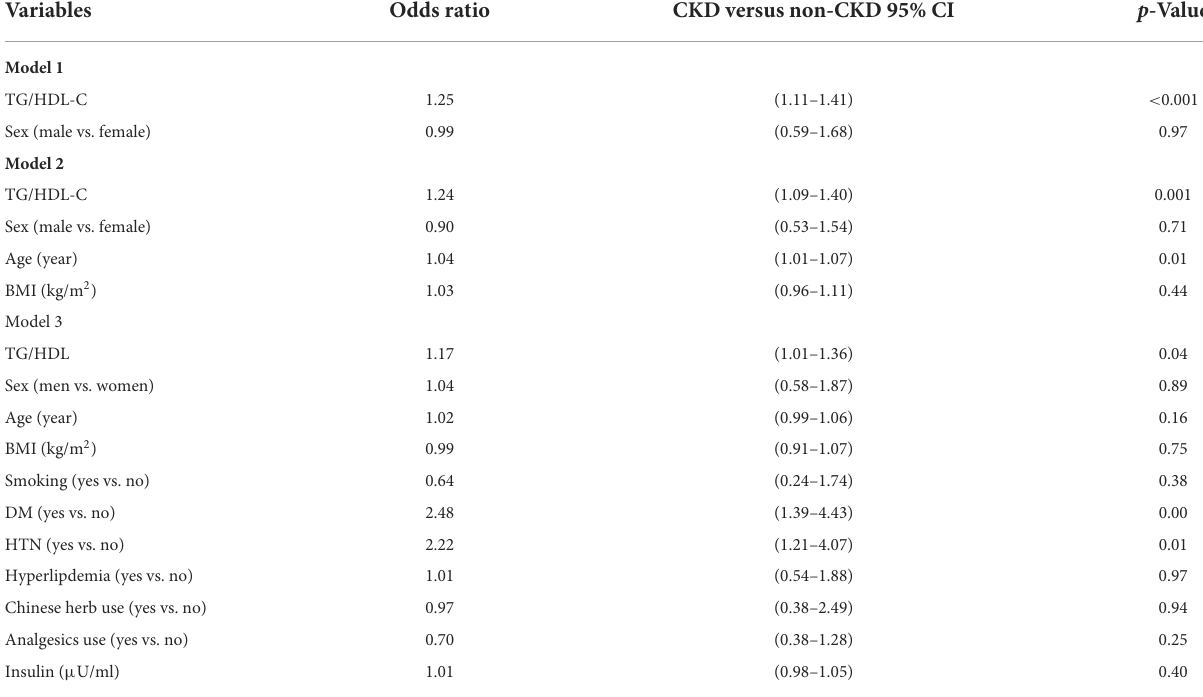
TABLE 3 Multiple logistic regression on the factors related to chronic kidney disease (CKD) in the screened population ( n = 400).